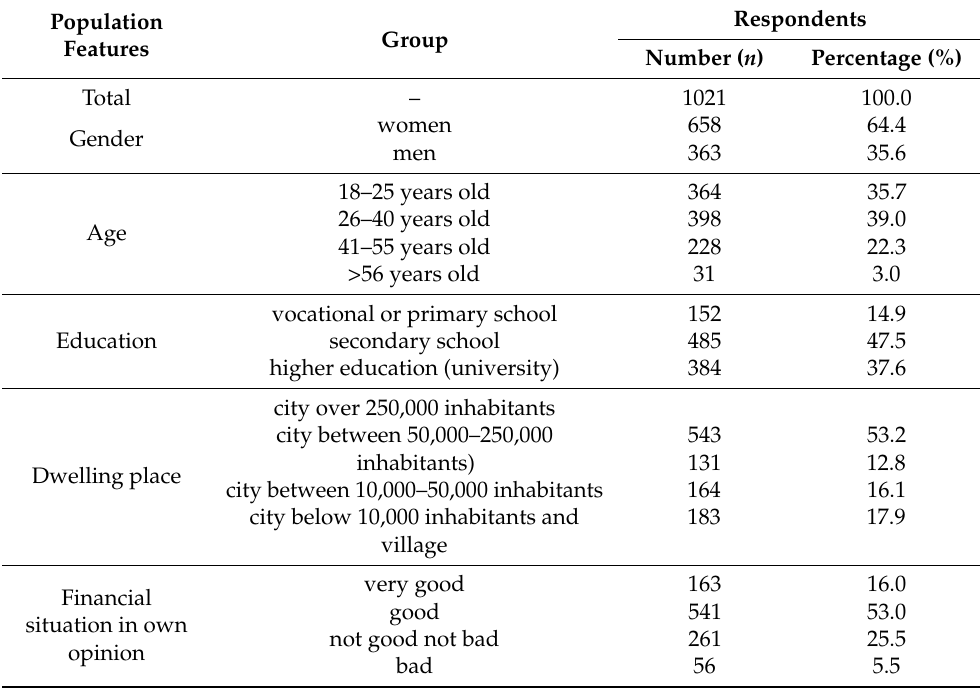
Table 1. Characteristics of the surveyed sample of respondents.